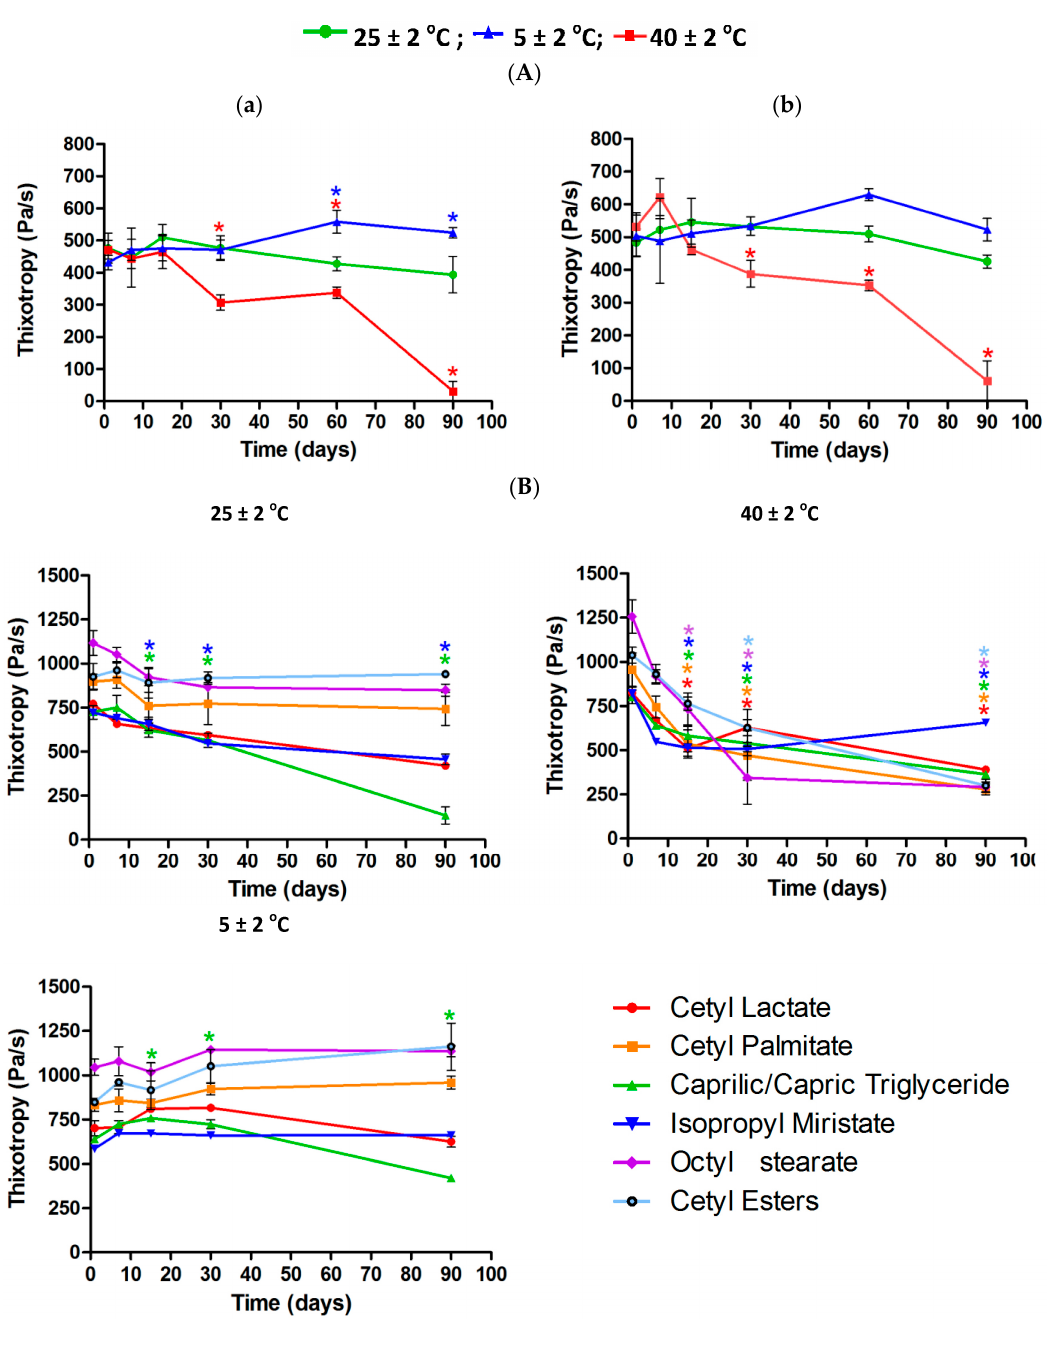
Figure 10. Thixotropy for 6.5 ( a ) and 7.0 ( b ) formulations ( n = 3) without ( A ) or with ( B ) fatty esters. (* Statistically significant differences were 95%, p ă